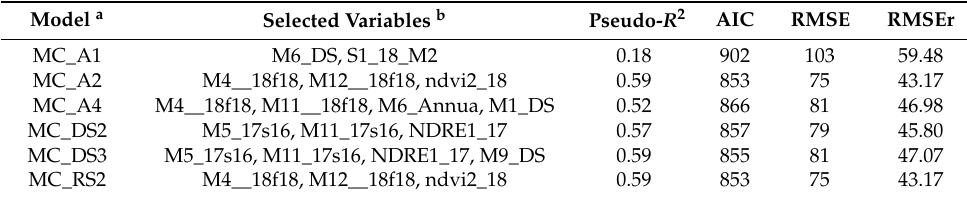
Table 5. Fitted models, selected variables from the centroid approach (MC), Pseudo- R 2 , AIC, RMSE, and RMSEr.